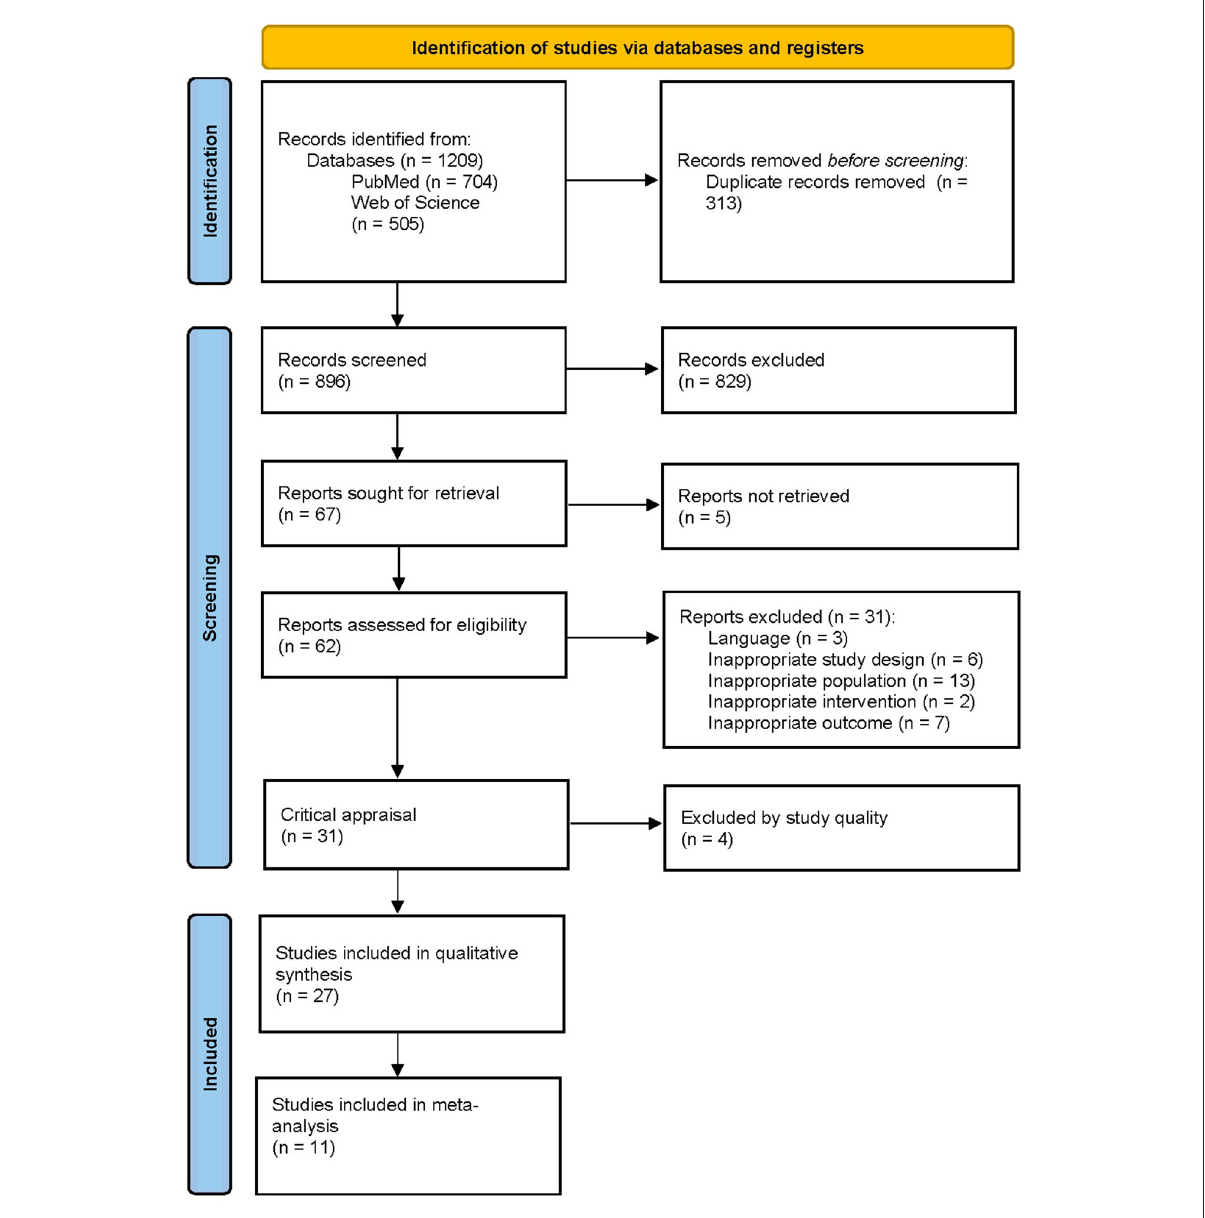
FIGURE2 PRISMA flowchart of the study selection procedure. From: Page et al.